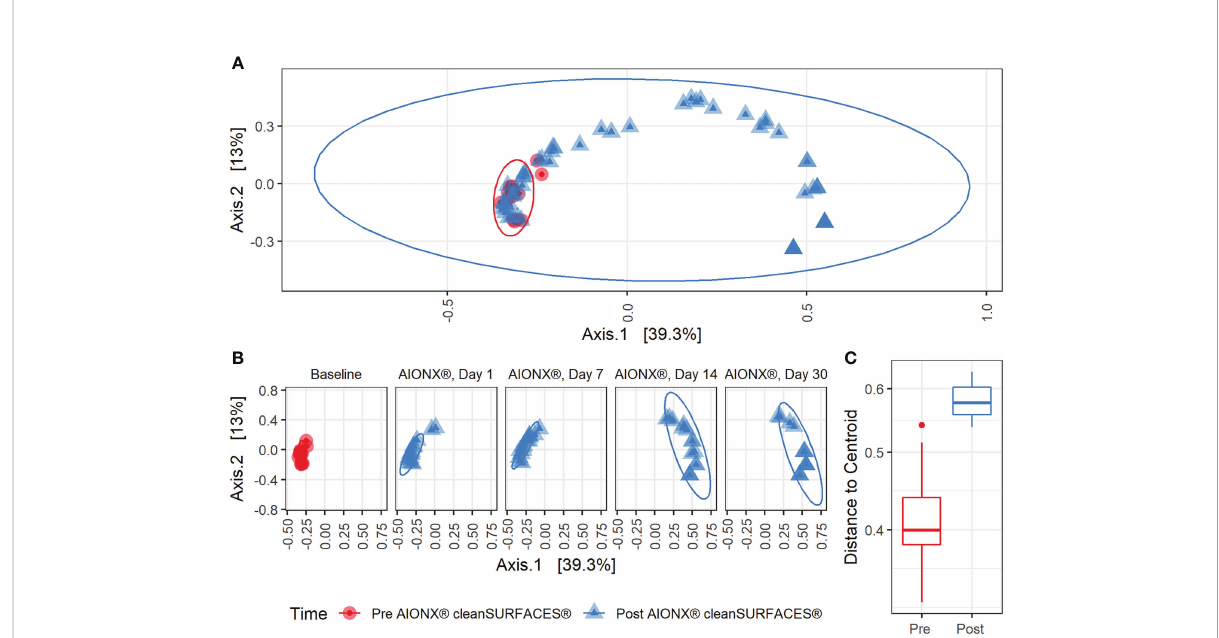
FIGURE 2 Beta Diversity during cleanSURFACES ® Intervention. Principal coordinates analysis (PCoA) of binary Jaccard distances between samples (A) before (red) and after (blue) the intervention of the AIONX ® cleanSURFACES ® . (B) Matched principal coordinates analysis strati fi ed by day reveals signi fi cant shifts in microbial community composition between samples when grouped by sampling day (adonis p < 0.001). (C) Boxplot comparing within-group unweighted jaccard distance dispersion before (red) and after (blue) the intervention of the AIONX ® cleanSURFACES ® .